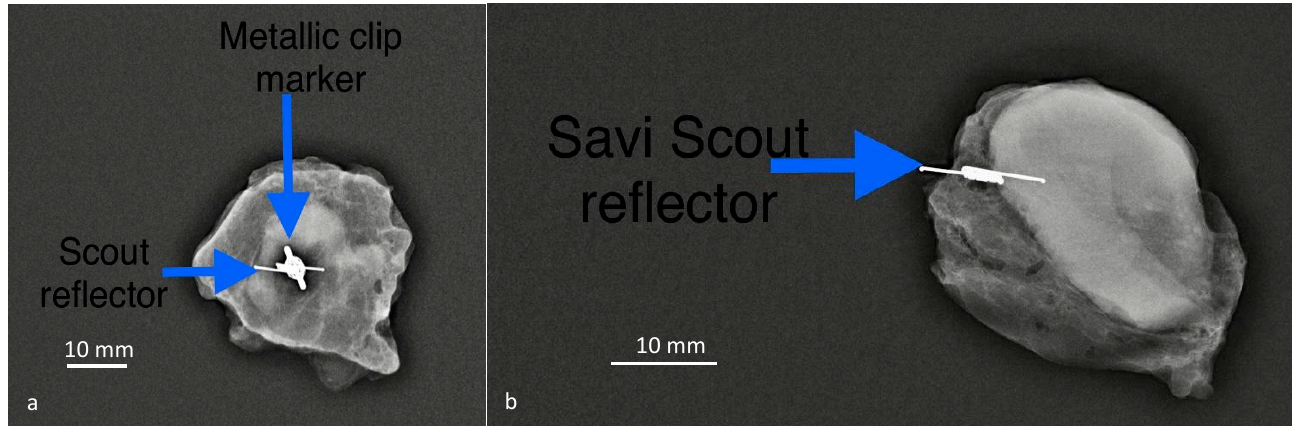
Figure 2. In ( a ), the patient had a metallic marker clip deployed within the pathological lymph node at the time of biopsy before neoadjuvant chemotherapy (NACT) and a second localization procedure using Savi Scout prior to surgery. In ( right ), the patient had the Savi Scout reflector at the time of biopsy prior to NACT thus avoiding a second procedure. There were no MRI artifacts related to the Savi Scout reflector in ( b ). The surgical procedure of identification and retrieval of the Savi Scout reflector took 15 min. Scale bar: 10 mm.